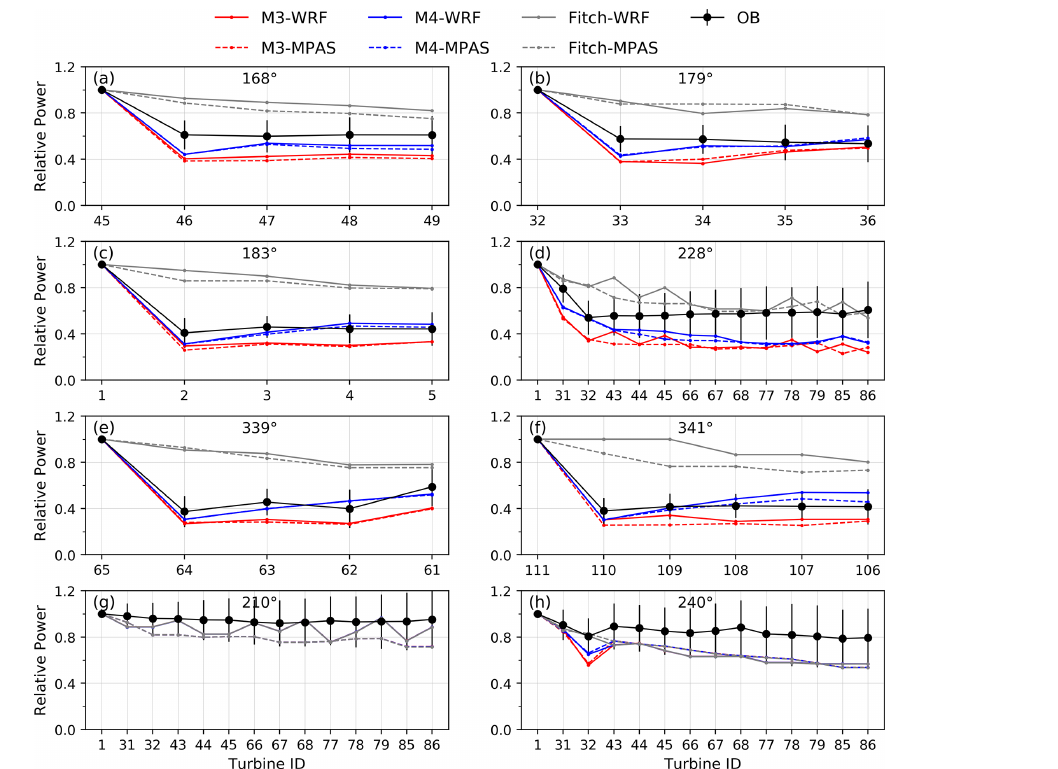
Figure 9. Same as Fig. 4 but for Anholt multi-cell cases with (cid:49)x = 1km.